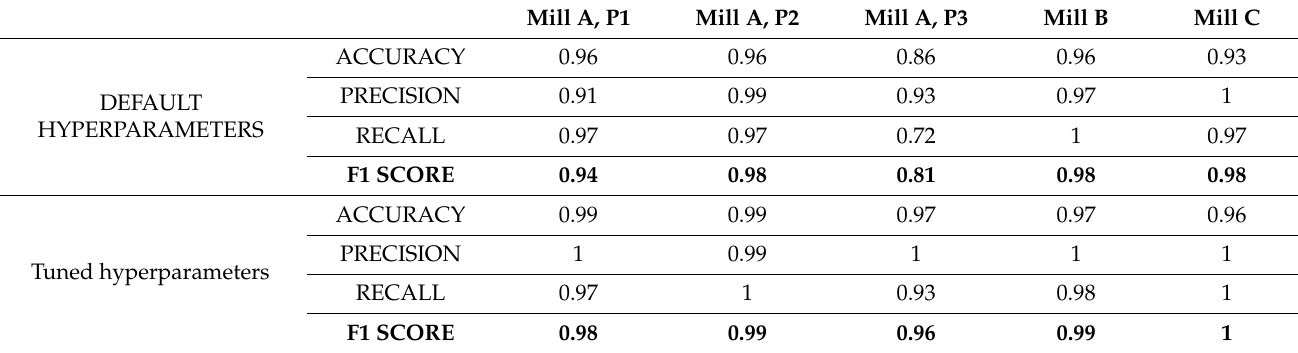
Table 7. Comparative results of algorithm